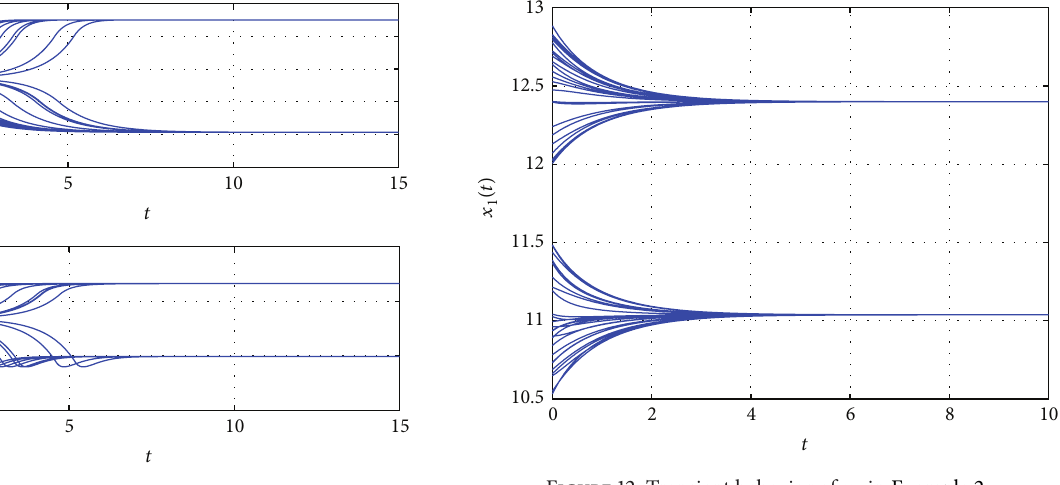
Figure 10: Transient behavior of 𝑥 1 and 𝑥 2 near the equilibrium point (−100/361, 482/361, −50/361, 120/361) 𝑇 in Example 1.